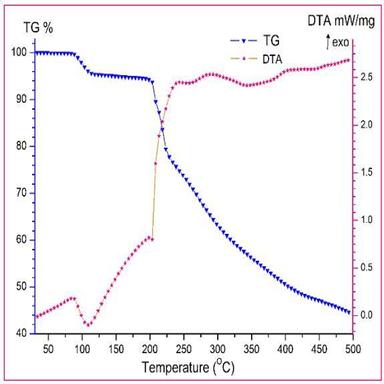
TG/DTA curves of HAPH